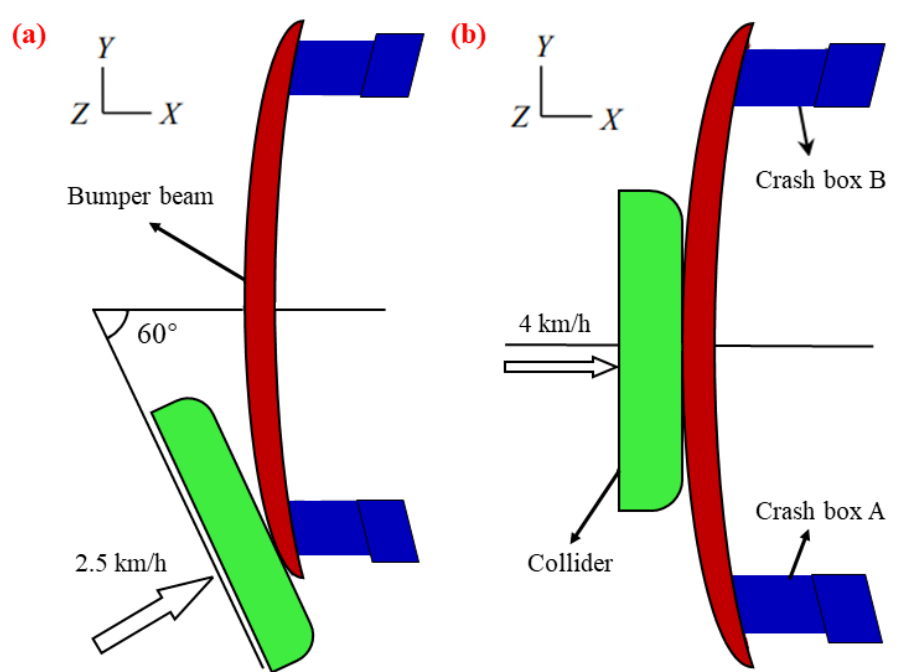
Figure 12. Tests specified of ( a ) angular collision and ( b ) center collision in GB17354-1998 [37].